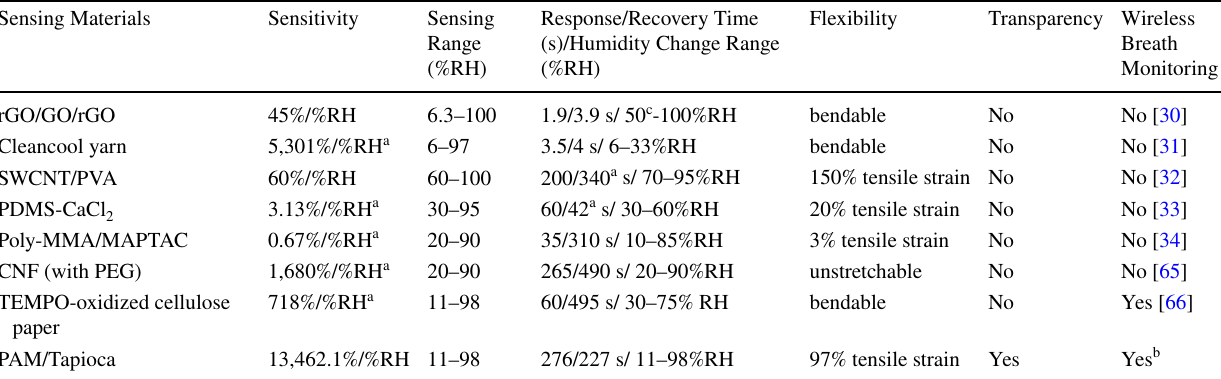
Table 1 Comparison of the performances of humidity sensors based on various sensing materials